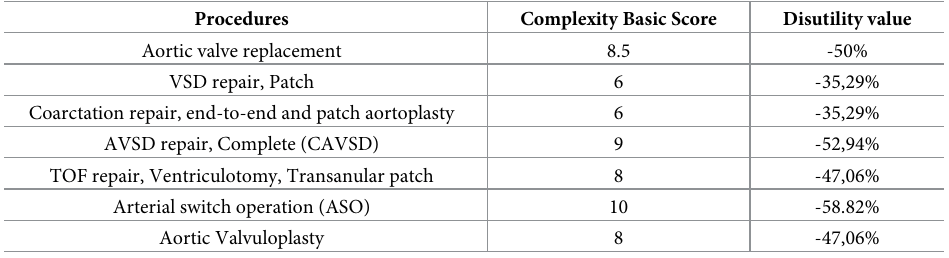
Table 7. Basic Aristotle complexity score and short-term (monthly)